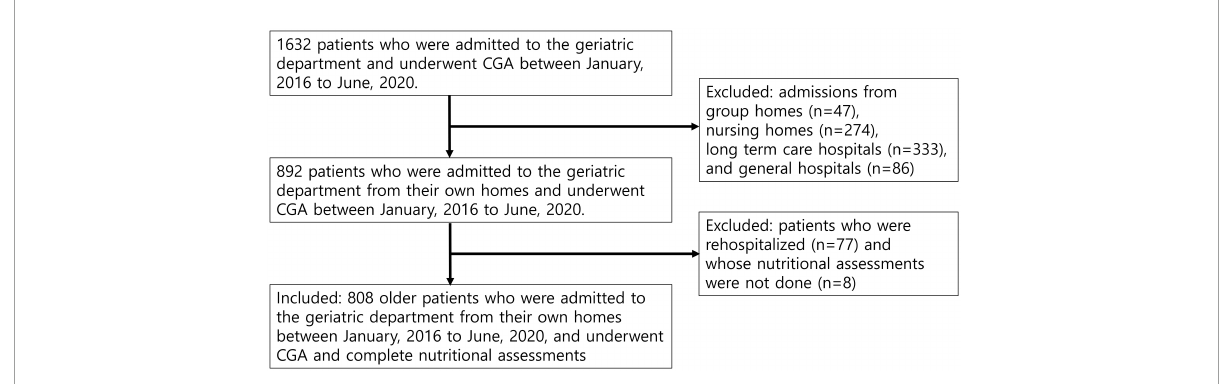
FIGURE1 Flow of patients through the study. The study participants consisted of 808 older hospitalized patients admitted from their own homes to the geriatric department ward and underwent comprehensive geriatric (CGA) and complete nutritional assessments.